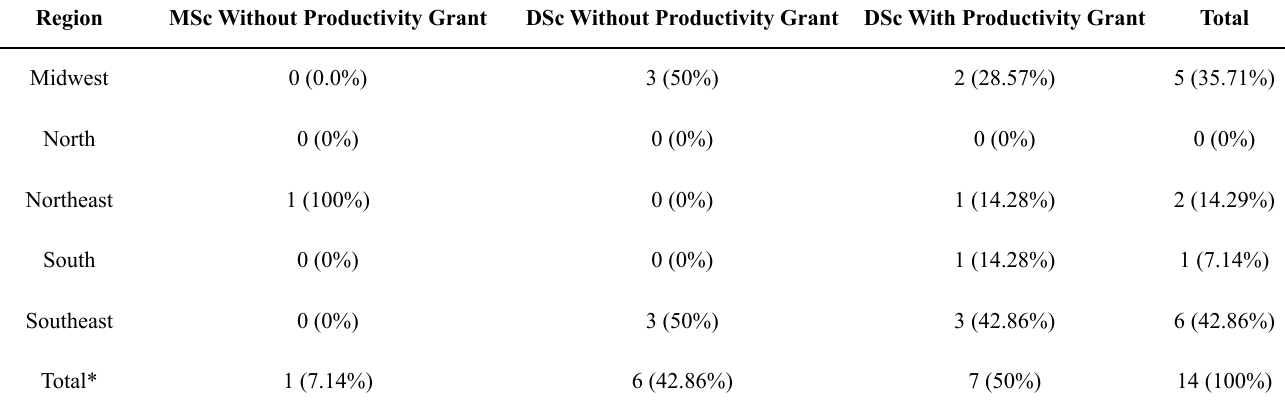
* Values given as frequency and percentage values in relation to total